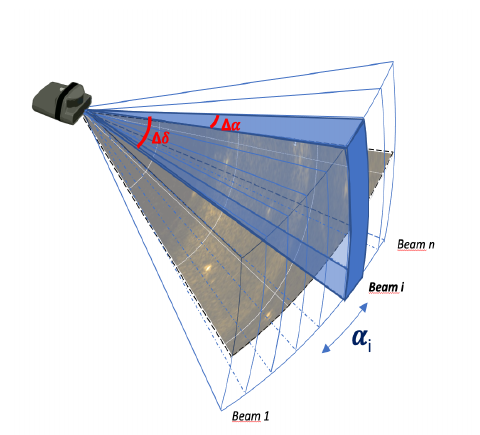
Figure 4. Forward Looking Sonar: target rectangular coordinates ( X S , Y S , Z S ) and polar coordinates ( ρ , α , δ )